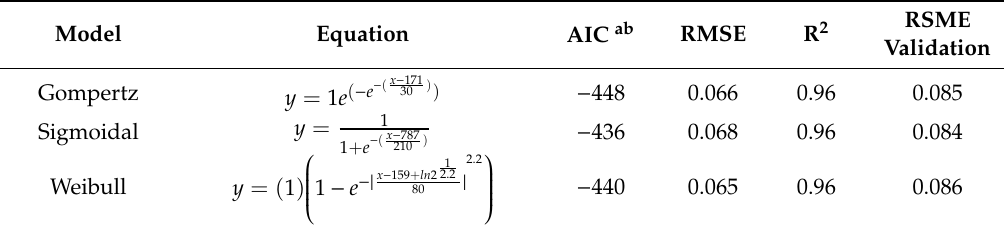
Figure 2. Relative cumulative pixels over time in days (gray circles). Three different equations were fit to the data as a predictive model for emergence of Senna obtusifolia : Sigmoidal (red dashed line), Gompertz (solid line), and Weibull (green dotted line).